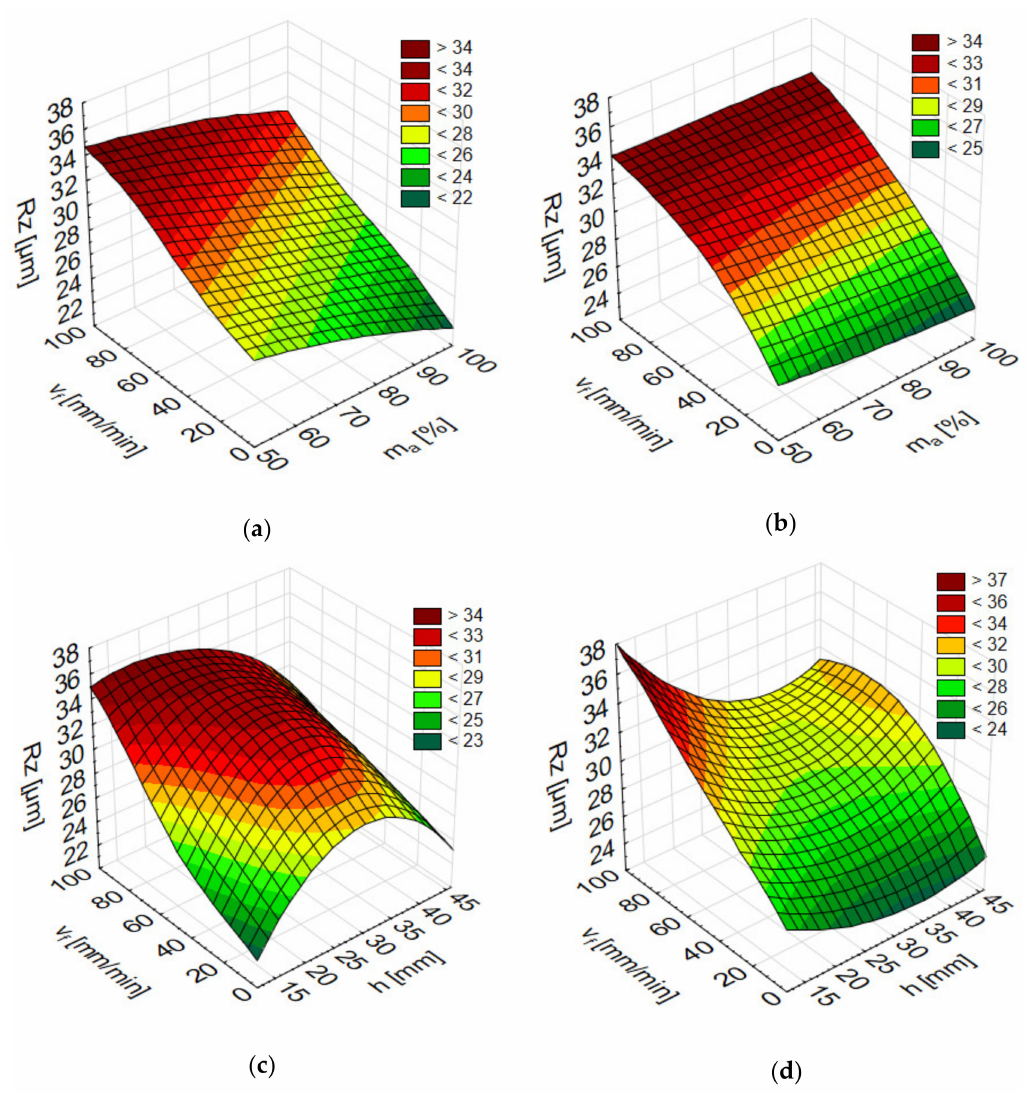
Figure 9. Numerical results of surface roughness parameters Rz after AWJ depending on the jet feed rate v f and abrasive flow rate m a for ( a ) AlSi21CuNi alloy (MLP 3-2-1) and ( b ) AlSi10Mg alloy (MLP 3-14-1), and depending on the jet feed rate v f and sample height h for ( c ) AlSi21CuNi alloy (MLP 3-2-1) and ( d ) AlSi10Mg alloy (MLP